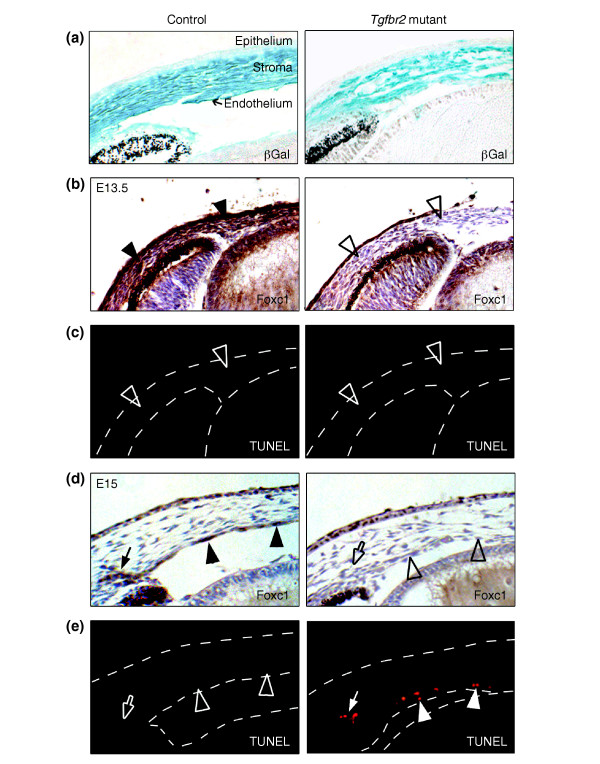
Tgfbr2-mutant mice lack corneal expression of the transcription factor Foxc1. (a) In vivo fate mapping at E15 (βGal, blue) demonstrates that NC-derived cells have correctly migrated into control and Tgfbr2-mutant eyes, contributing to corneal stroma and endothelium. (b) At E13.5, the periocular mesenchyme of control eyes is positive for Foxc1 antibody staining (brown; arrowheads), whereas Foxc1 is undetectable in corresponding structures of Tgfbr2-mutant eyes (open arrowheads). (c) No apoptotic cells are found in either control or Tgfbr2-mutant eyes at E13.5 by TUNEL analysis (open arrowheads). (d) At E15, the eyes of control embryos show strong expression of Foxc1 (brown) in the forming trabecular meshwork (arrow) and in corneal endothelial cells (arrowheads). In Tgfbr2-mutant eyes, NC-derived cells localize to the cornea, but Foxc1 is undetectable in prospective endothelial cells (open arrowheads) and in the forming trabecular meshwork (open arrow). (e) At E15, cells that fail to express Foxc1 in Tgfbr2-mutant eyes appear to undergo apoptosis, unlike in control eyes, as revealed by TUNEL analysis (red).